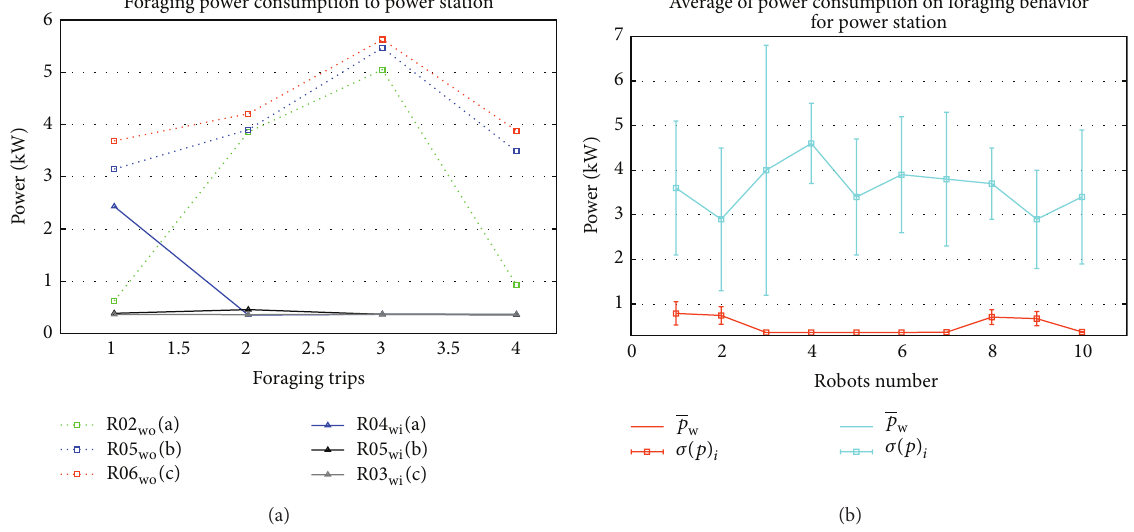
Figure 12: Analysis of foraging power consumption in environment with knowledge sharing and without knowledge sharing by (a) 3 selected mobile robots in each environment and (b) average and standard deviation of power consumption in foraging behavior.